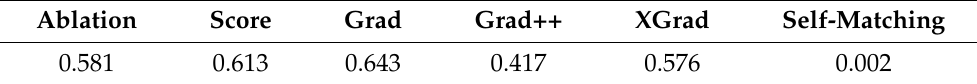
Table 2. Class_drop for conservation